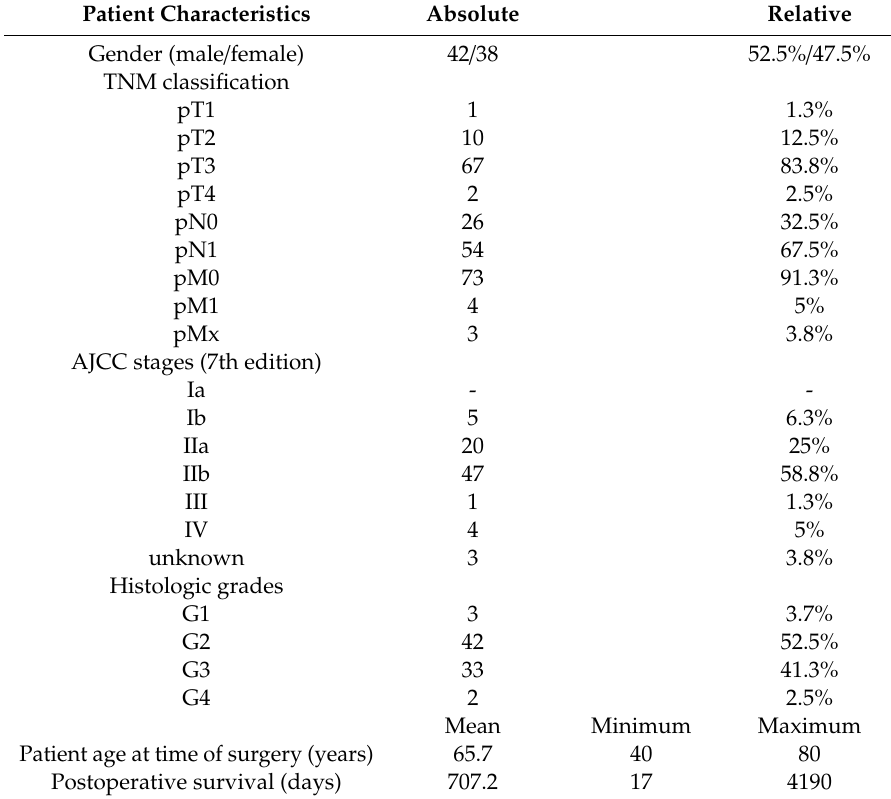
Table 1. Patient characteristics of the patient